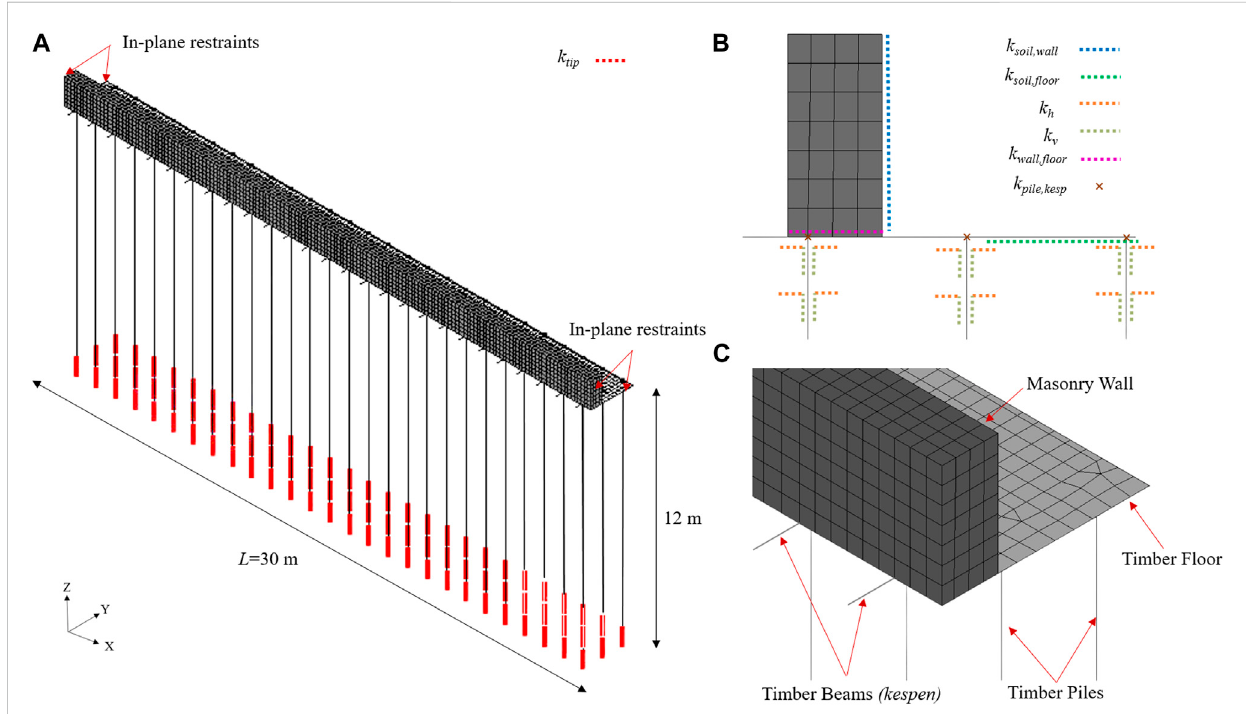
FIGURE 6 Numericalmodeladoptedfortier2oftheprocedureusedtoassesstheresponseof Marnixkade undertraf fi cloading: (A) generalisometricview; (B) transversal cross-section highlighting different interface elements; (C) close-up of the general isometric